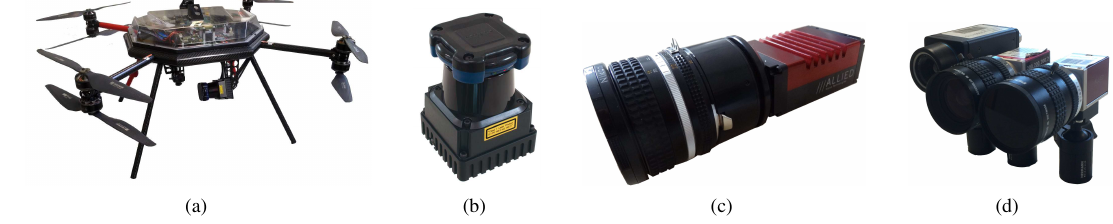
Figure 2: (a) ADFEX copter Goliath Coax 8 from CADMIC. (b) Laser scanning range finder Hokuyo UTM-30LX-EW (Hokuyo,